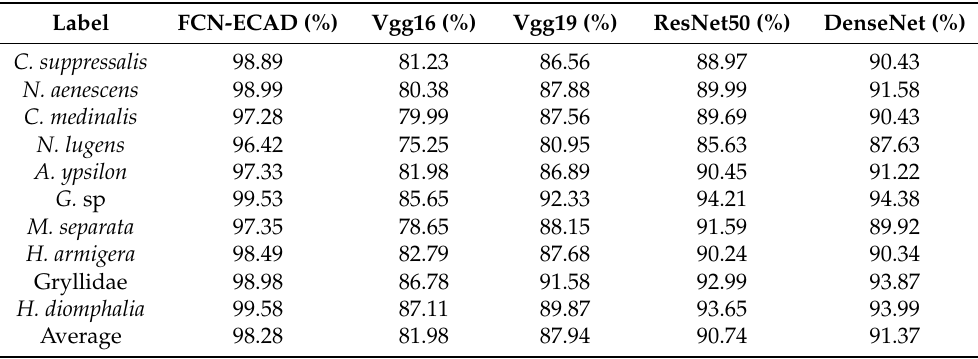
Table 4. Classification results of different kinds of pests.